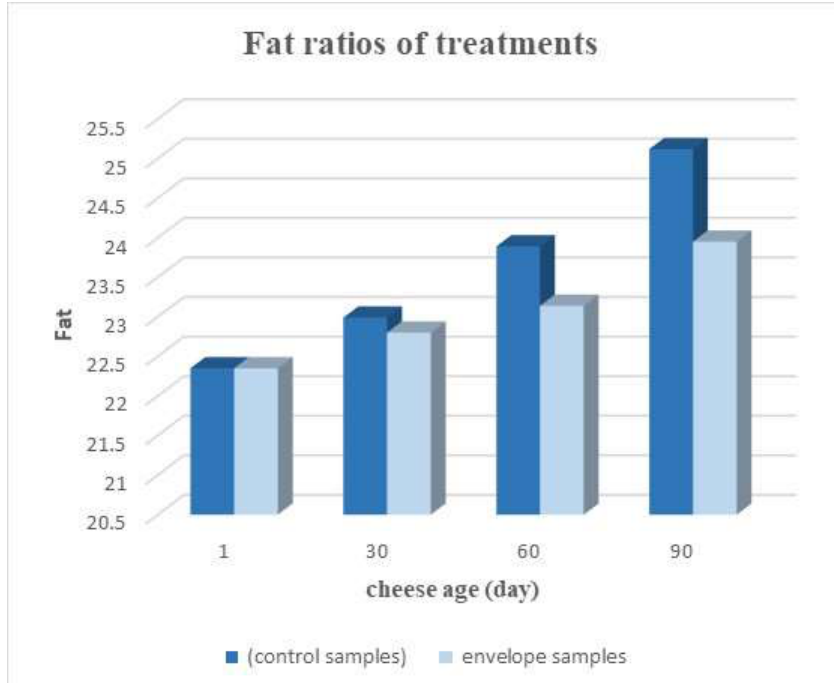
Figure 3: Fat ratios of treatments for unwrapped mozzarella cheese (control sample) and cheese samples coated (enveloped sample) during storage